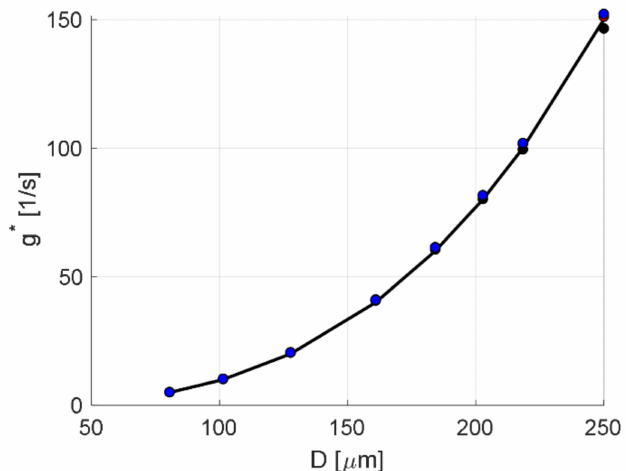
Figure 8. Case A: Homogenous flow and breakup frequency. Set breakup frequency (line) compared to global estimate (markers) at different drop diameters, D . Results from three flow conditions: U g = 1.5 m/s ( black ), U g = 3.0 m/s ( red ) and U g = 6.0 m/s ( blue